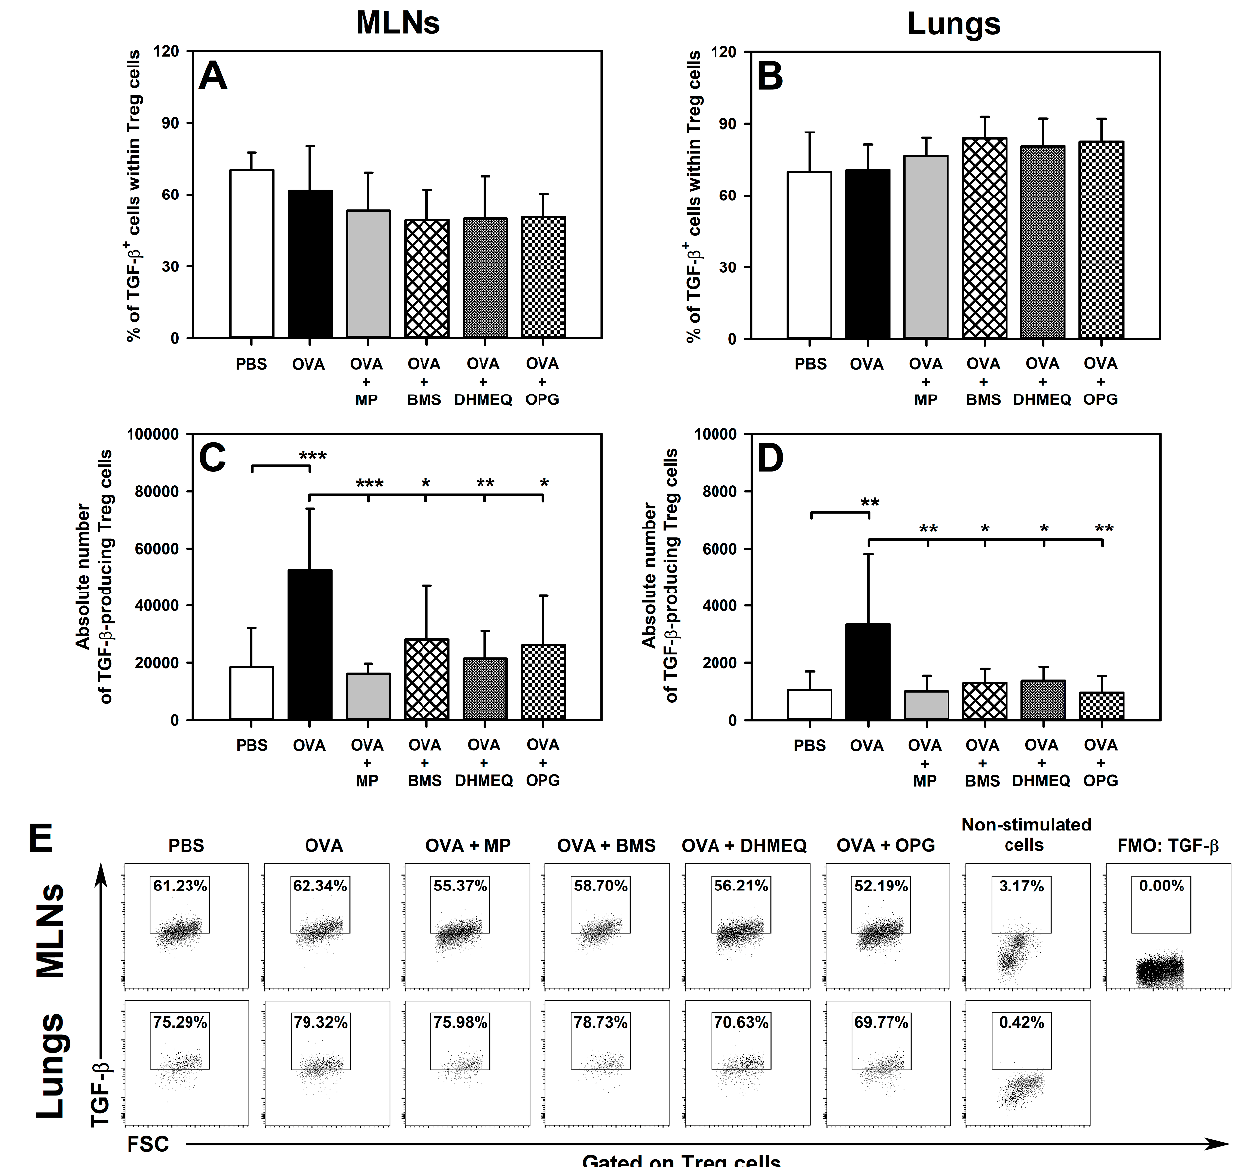
Figure 5. Effect of inhibitors of IKK (BMS-345541 (BMS)), NF- κ B translocation (dehydroxymethylepoxyquinomicin (DHMEQ)) and RANK/RANK-L interaction (osteoprotegerin (OPG)), and glucocorticosteroid (methylprednisolone (MP)) administration on the number of TGF- β -producing Treg cells. The relative count ( A , B ) is expressed as a percentage of TGF- β -producing cells within Foxp3 + CD25 + CD4 + T cells. The absolute count ( C , D ) represents the number of TGF- β -producing Foxp3 + CD25 + CD4 + T cells per MLN or lung sample collected from individual mice. * p < 0.05, ** p < 0.01, *** p < 0.001. Examples of dot plot cytograms showing the distribution of TGF- β -producing and non-producing cells within Treg cells ( E ).